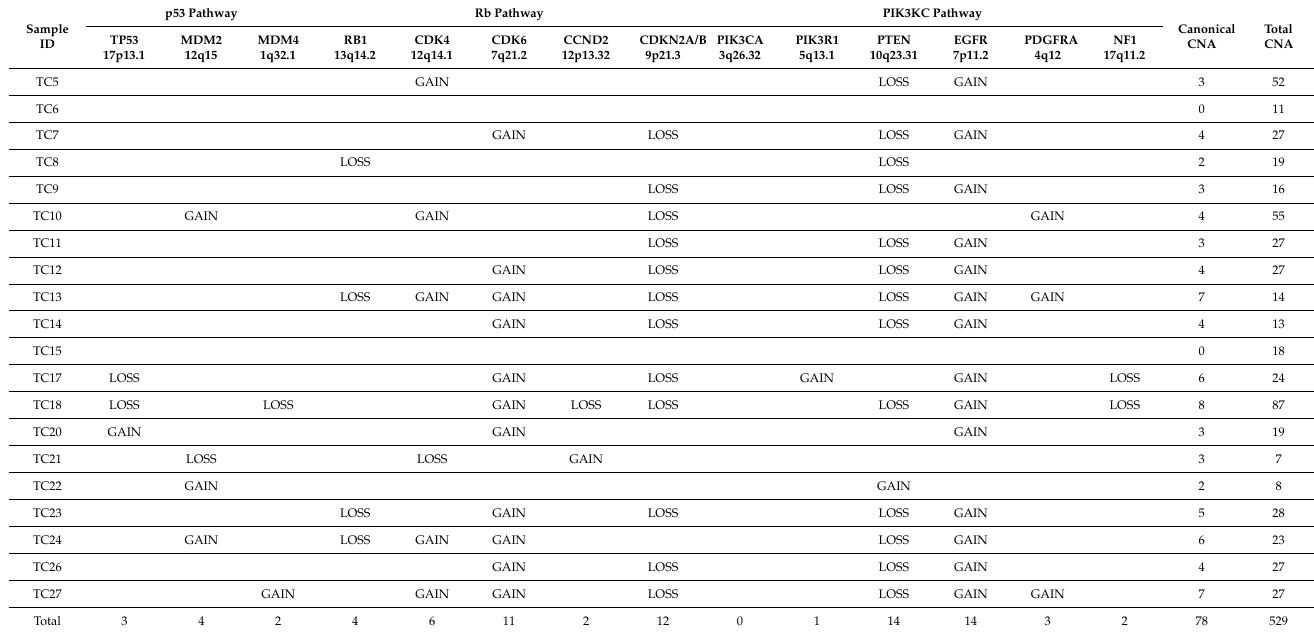
Table 2. Summary of copy number alterations affecting the three main canonical pathways altered in high-grade gliomas. The analysis was conducted on patient tumor core biopsies (TCs). The canonical CNAs load (Canonical CNA) and the total burden of imbalances (Total CNA) per sample were also reported.